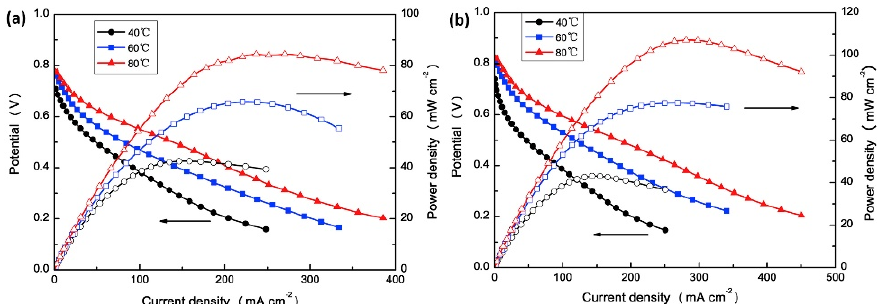
Figure 6. Polarization and power density curves of DMFC using ( a ) QS/PVA and ( b ) QS/PVA-1% LDH@CNTs electrolytes at different operating temperatures. Reprinted with permission from Ref. [6]. Copyright 2019